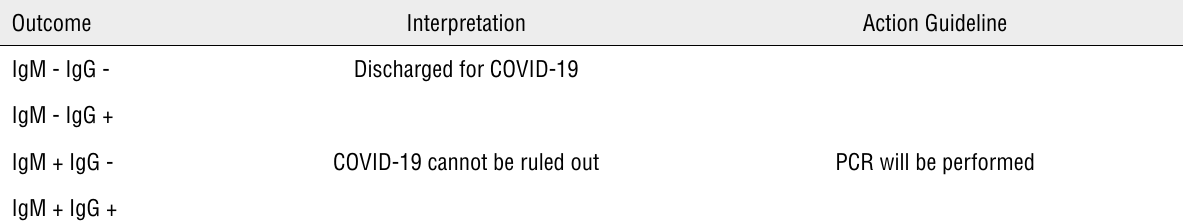
Table 2 - Rapid tests in asymptomatic professionals. April